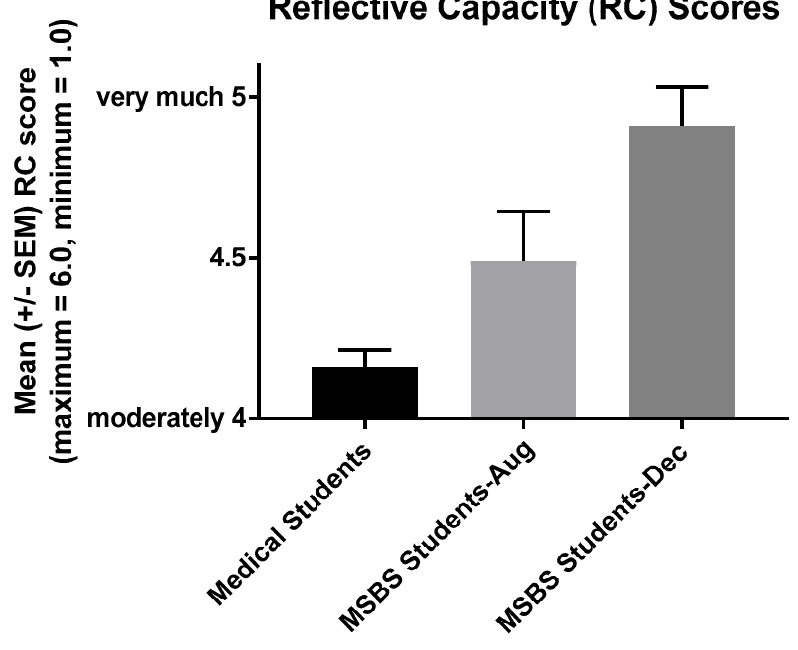
Figure 3. Increase in reflective capacity scores of prospective medical (MSBS) students in association with written reflection on service-learning between August and December 2018. The mean response of MSBS students increased from closer to “moderately” in August to near “very much” in December for 16 statements concerning self-reported reflection. ANOVA with multiple comparison tests revealed both a statistically significant increase in MSBS student scores ( p = 0.03) and that MSBS student scores in August ( p = 0.03) and December ( p < 0.0001) were higher than a sample of graduating medical students [21]. F = 16.83, r = 0.43, p < 0.0001.